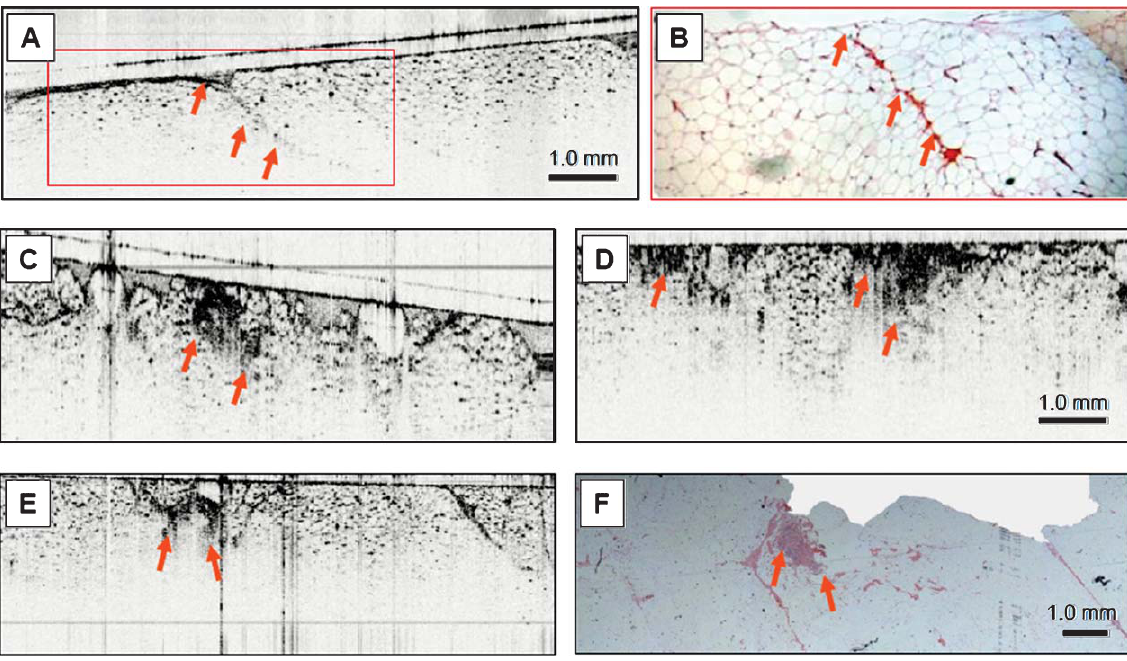
Fig. 7. Intra-operative surgical margin assessment with OCT, and corresponding histology, from a breast cancer lumpectomy procedure. (A) OCT image of a negative surgical margin composed primarily of adipose tissue. The small dark highly scattering point-like features correspond to individual nuclei of adipocytes, and arrows indicate vasculature. (B) Corresponding histology. (C) OCT image of a positive margin with ductal carcinoma in situ (arrows indicate dense highly-scattering features corresponding to tumor cells). (D) OCT image of a positive margin with invasive ductal carcinoma (tumor cell features indicated by arrows). (E) OCT image and (F) corresponding histology of a small isolated focus of tumor cells at the surgical margin. Figure used with permission from